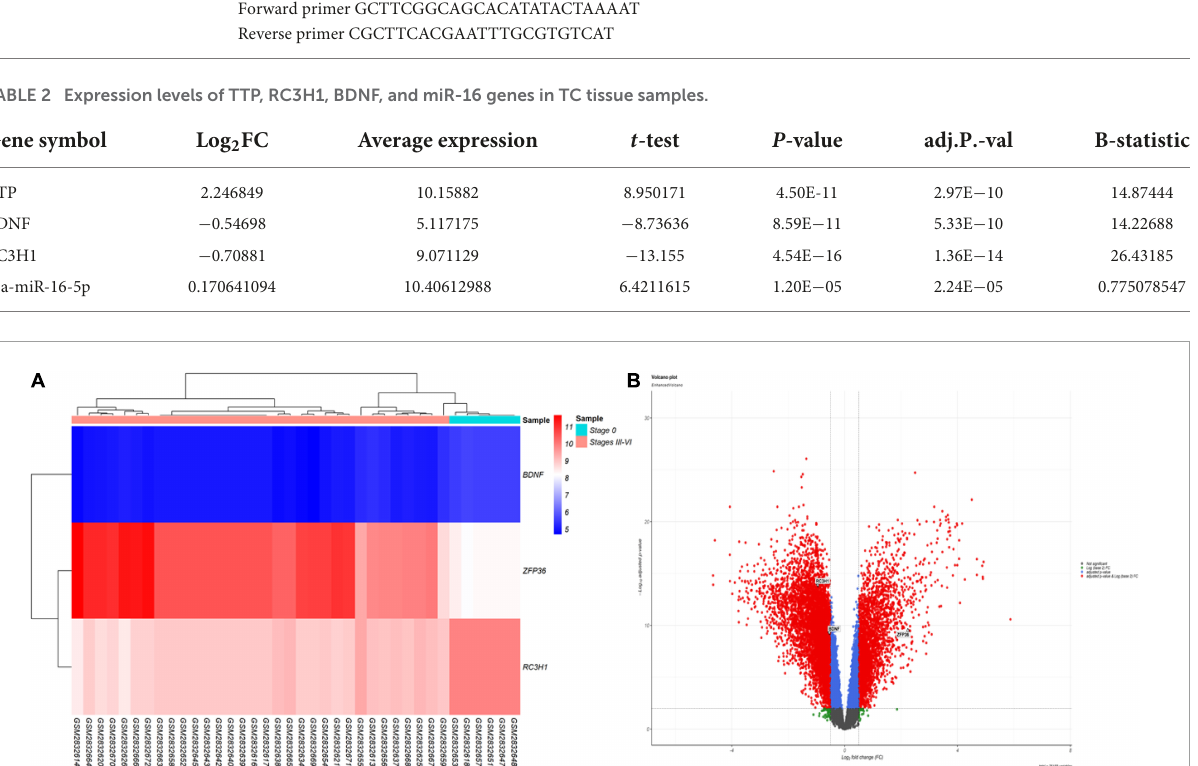
FIGURE2 Differentially expressed mRNAs in brain samples from patients with AD in Braak stages III to VI and control (CTL) samples. (A) Gene-specific heatmaps for the BDNF, TTP, and ROQUIN genes. Genes with a high level of expression are depicted in red, whereas those with a low level of expression are displayed in blue. (B) The DEGs’ volcano plan. Screening for DEGs was done using a | (log 2 FC) | > 0.5 and an adjusted p -value 0.001.